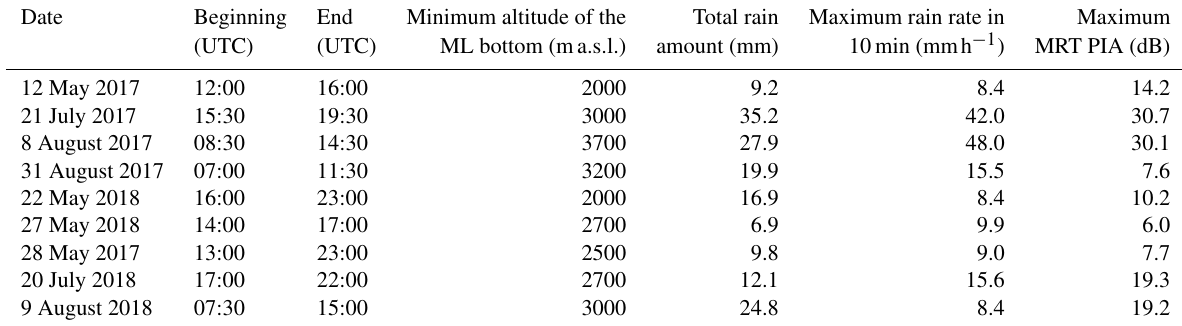
Table 2. Some characteristics of the nine convective events considered in the study of the φ dp –PIA relationship in rain. The ML detection was performed with the 25 ◦ elevation angle measurements of the XPORT radar using the algorithm described in Khanal et al. (2019). The total rain amount and the maximum rain rate are recorded at the weather station available at the XPORT radar site at IGE. The maximum PIA is derived from the MRT by considering the 7.5 ◦ elevation data of the XPORT radar. Beginning End Minimum altitude of the Total rain Maximum rain rate in Maximum (UTC) (UTC) ML bottom (ma.s.l.) amount